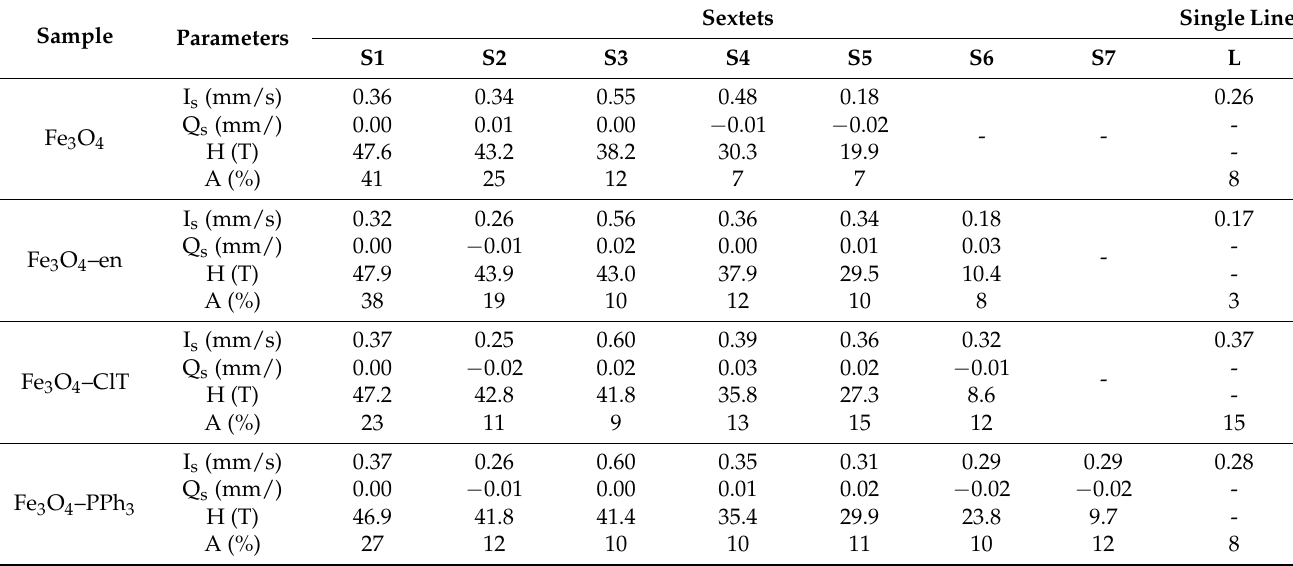
Table 3. Hyperfine parameters of the synthesized samples (isomer shift ( I s ), quadrupole splitting ( Q s ), hyperfine magnetic field ( H ), and relative area ( A